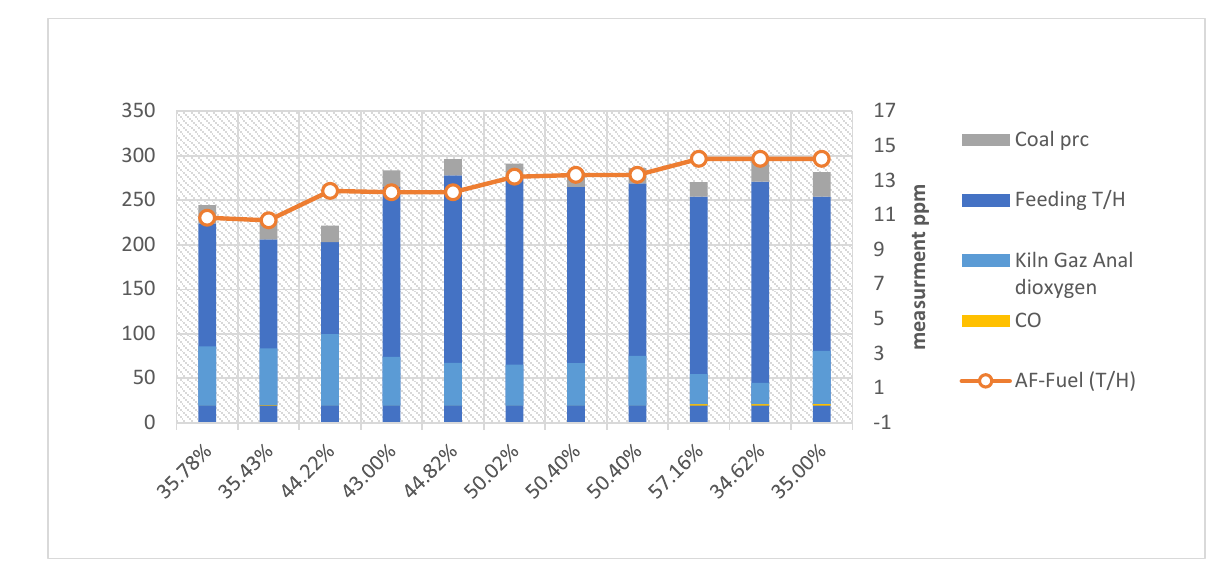
Figure 4. AF substitution operation analyses.